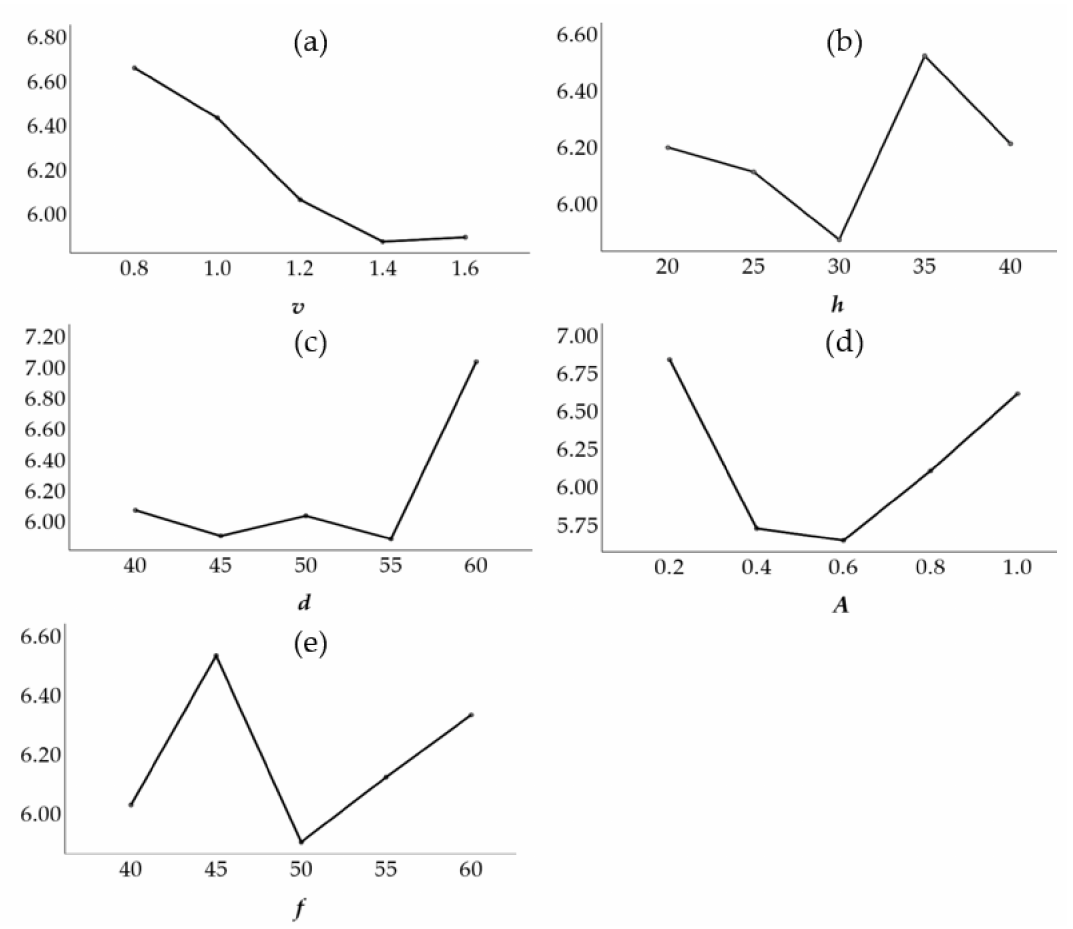
Figure 12. Fold chart of effects for each factor: ( a ) v , ( b ) h , ( c ) d , ( d ) A , ( e ) f